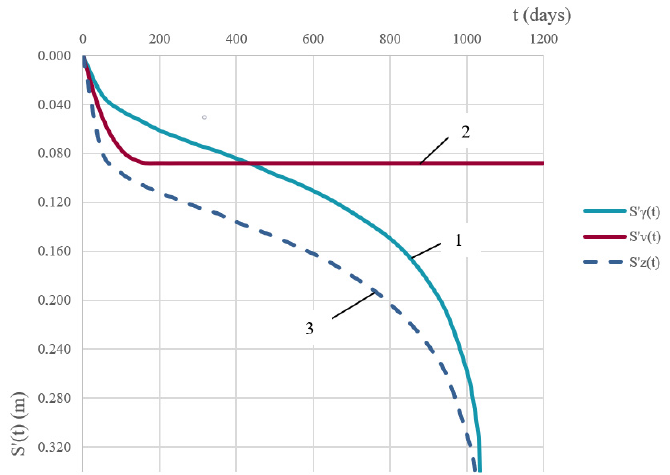
Figure 8. Soil base settlements S’(t)–t : 1: determined using the Ter-Martirosyan model; 2: determined using the Kevin–Voigt model; 3: total deformations determined using Formula (15).